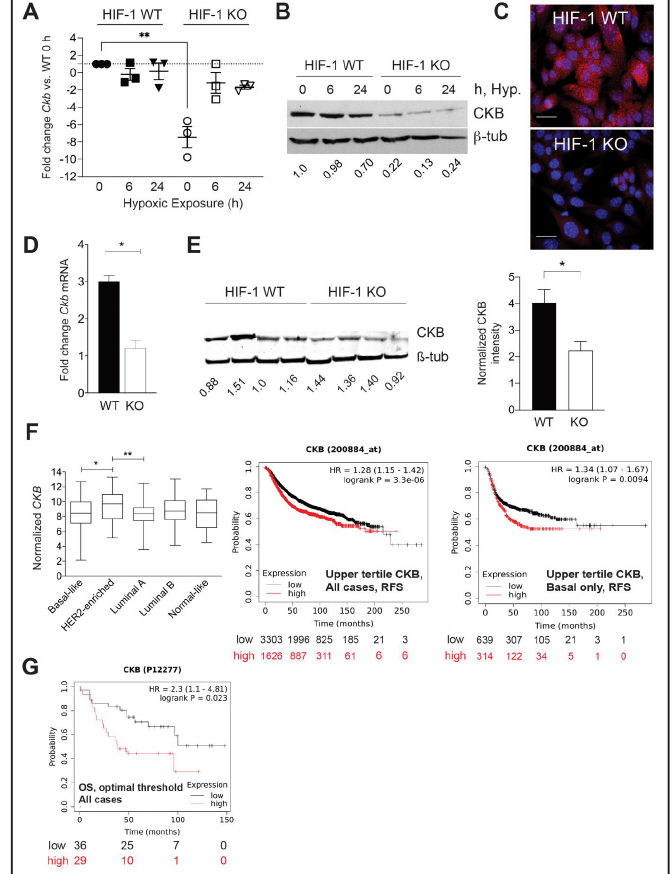
Figure 1. CKB expression in HIF-1 WT and KO PyMT cells and in end-stage tumors, and correlation with prognosis in clinical datasets. ( A ) Scatter plot of the mean fold change ± SEM in Ckb mRNA levels relative to HIF-1 WT cells at normoxia (0h of hypoxic exposure). Each data point represents the mean of 3 technical replicates for an independent qPCR assay from a biological replicate experiment, and the overall mean of three biological replicates is shown. ( B ) PyMT cells were grown to 80% confluence and subjected to hypoxic culture for either 6 h or 24 h, or cells were continuously cultured at normoxia, such that the 0 h sample was harvested on the same day as the 24 h hypoxic sample. ( A ) Representative Western blot for CKB or β -tubulin (loading control) is shown. ( C ) Immunostaining for CKB (red) in HIF-1 WT and KO cells, counterstained with DAPI. Images were captured at 630 × magnification (scale bar indicates 20 µ m). ( D ) Ckb mRNA levels were compared in end-stage HIF- 1 WT and KO tumors by qPCR. Data are expressed as the overall mean fold change ± SEM between